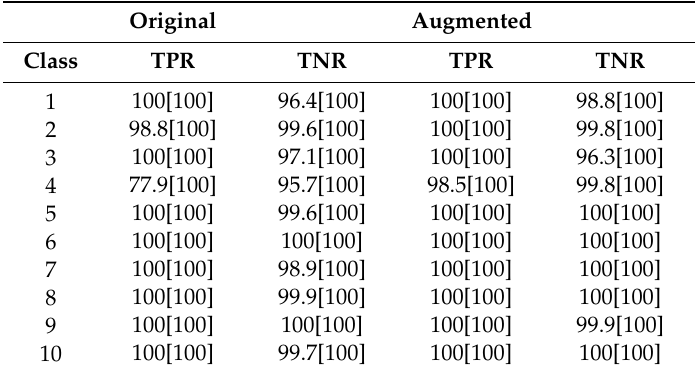
Table 2. Comparative experiments with Compact CNN on original and augmented datasets (Our results are marked with square brackets. TPR: True Positive Rate; TNR: True Negative Rate).